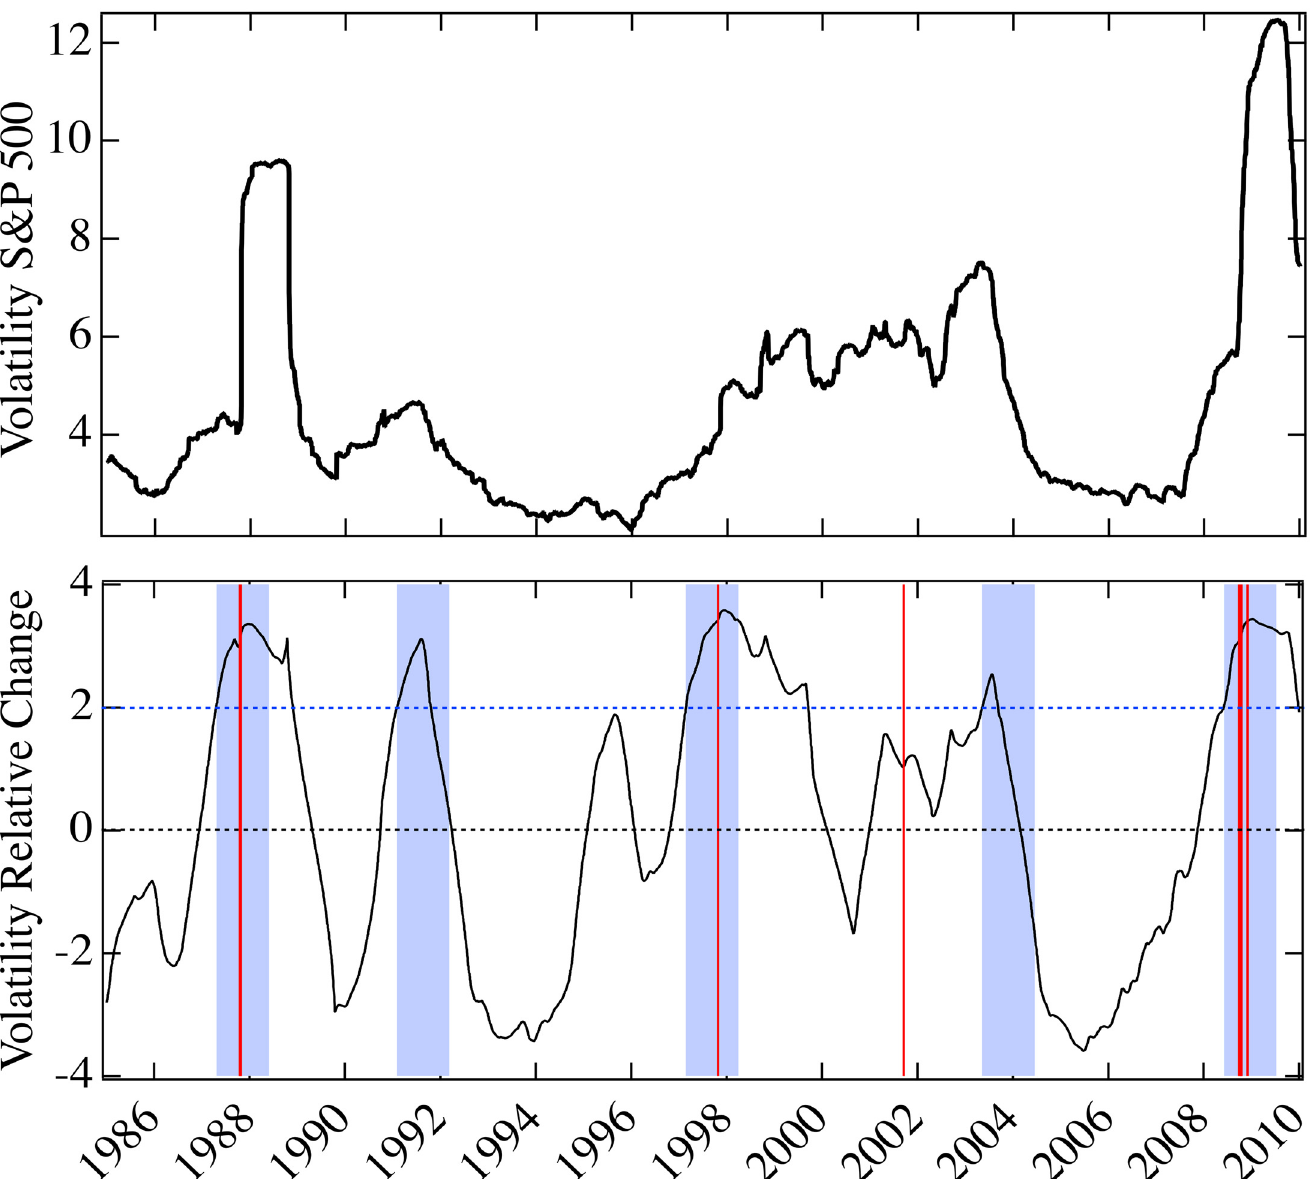
Fig 6. Annual relative change in volatility for the period 1985 – 2010. Top panel is the volatility of the S&P 500 index, from 1985 to 2010, averaged over the previous year. Bottom panel is the annual change of volatility as a fraction of its standard deviation computed over the previous year. Four year-long windows (shading) follow two standard deviation increases in volatility greater than twice the standard deviation from one year earlier, after periods of decline. One day crashes are as in Fig 3 (vertical red lines). This indicator generates 3 true positives, 2 false positives and 1 false